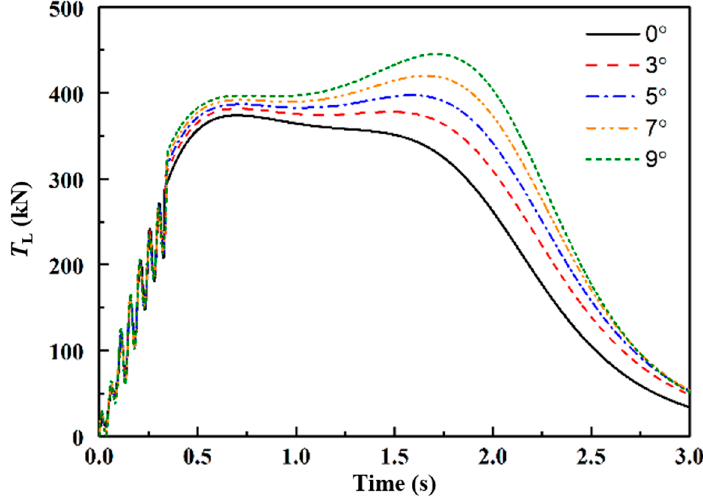
Figure 12. The port tape tension.